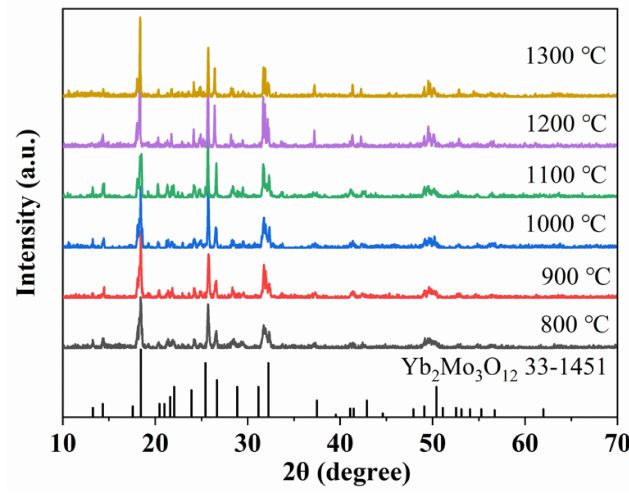
Figure 2. Preparation of temperature-dependent XRD patterns of Tb 3+ -doped Lu 2 Mo 3 O 12 and reference data.